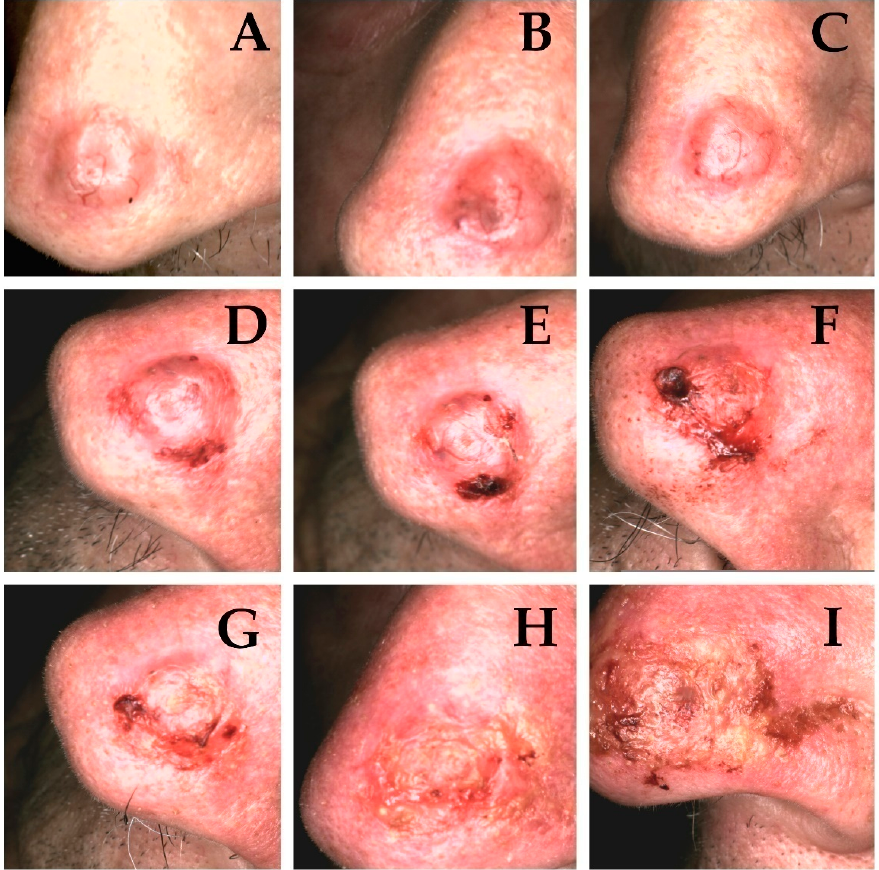
Figure 4. Clinical presentation of basal cell carcinoma of the nose of 83-year-old patient, nodular type. ( A )—Tumour before treatment, with visible—erythematous nodule, short vessels and telangiectasia. ( B – I )—evolution of tumour destruction with erosion arising in 4th fraction (t4) ( D ), evolving into ulceration with disappearing vessels in 6th fraction (t6) ( F ), and crust appearing in 7th fraction (t7) ( G ), with finally forming ulceration covered by scale and haemorrhagic crusts (t8–9) ( H , I ).